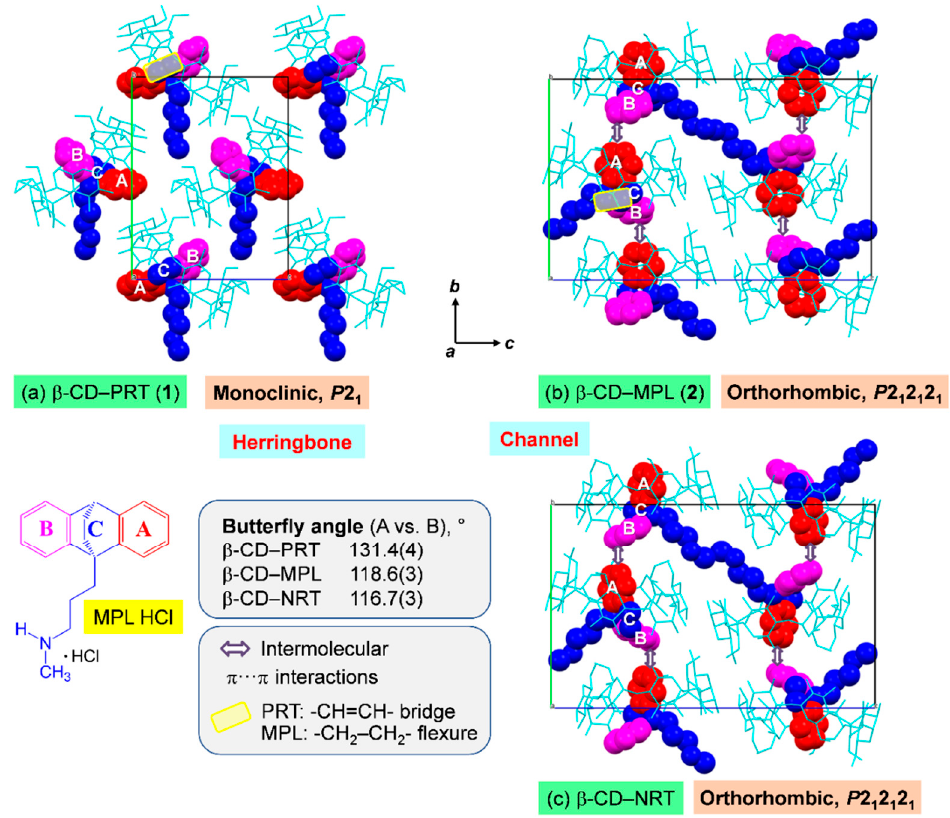
Figure 7. 3D arrangements of the inclusion complexes ( a ) β -CD–PRT HCl in monoclinic, P 2 1 ( 1 ) existing in the herringbone pattern, ( b ) β -CD–MPL HCl ( 2 ) and ( c ) β -CD–NRT HCl [23] both packing in the channel-type structure stabilized by intermolecular edge-to-face π ··· π interactions. β -CD, PRT, MPL, and NRT molecules are shown with cyan wireframes and space-filling models (A-ring = red; B-ring = magenta; C-ring and side-chain = blue). Water molecules, chlorides, and H atoms are omitted for clarity. Examples of the PRT -CH=CH- bridge and the MPL -CH 2 –CH 2 - flexure at the central C-ring are emphasized in yellow areas. Note the reverse inclusion modes of PRT B-ring and MPL A-ring in the β -CD cavity. TCAs composing the B-C-A rings and the side-chain are shown as an example for MPL HCl, and the butterfly angles are compared in the inset.